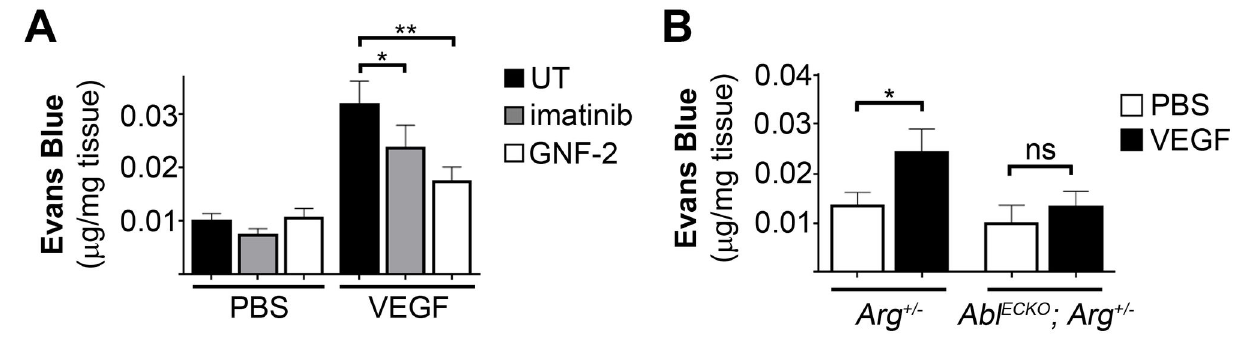
Figure 3. Abl kinases are required for VEGF-induced vascular permeability in vivo . ( A ) Evaluation of vascular leakage of Evans blue dye in mice following intradermal injection of VEGF (100ng, 15 minutes) with or without concomitant treatment with imatinib or GNF-2 (15μM). Dye extravasation was normalized to tissue weight. Values are presented as means +/- SD (n=12). ( B ) Quantification of VEGF-induced dermal vascular leakage of Evans blue dye in Abl ECKO ; Arg +/- (Abl flox/flox ; Arg +/- ; Tie2-Cre +/- ) and age/ sex-matched Arg +/- control mice (Abl flox/flox ; Arg +/- ; Tie2-Cre -/- ). Dye extravasation was normalized to tissue weight. Values are presented as means +/- SD (Arg +/- controls, n=8; Abl ECKO ; Arg +/- , n=6). *P<0.05; **P<0.01. doi: